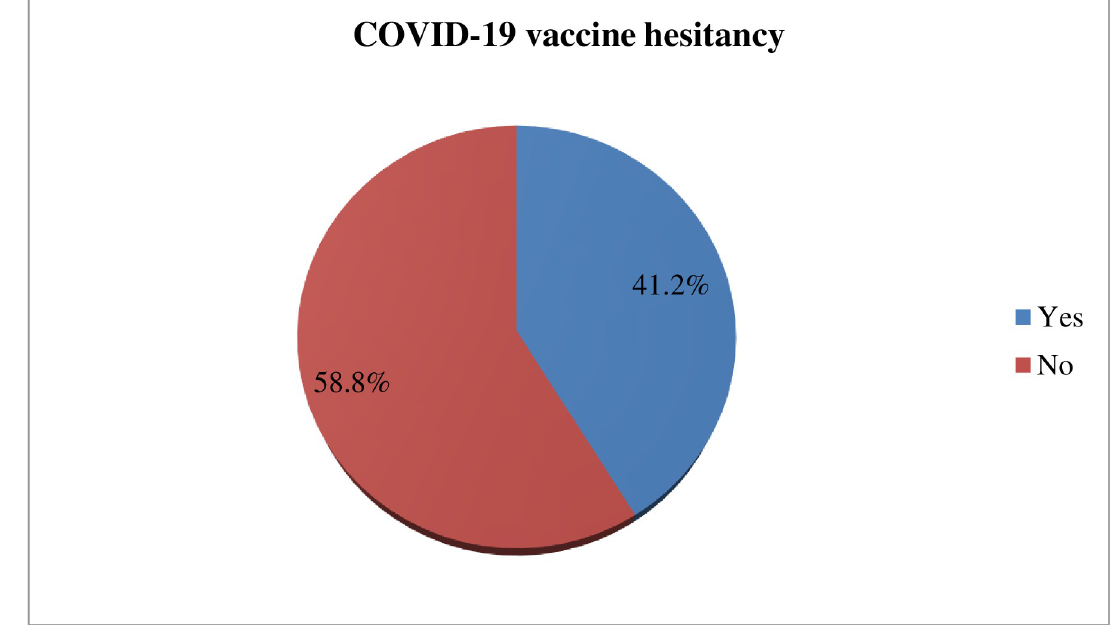
Fig 4. COVID-19 vaccine hesitancy among medical and health science students attending Wolkite University, Ethiopia, 2021 (n = 173).